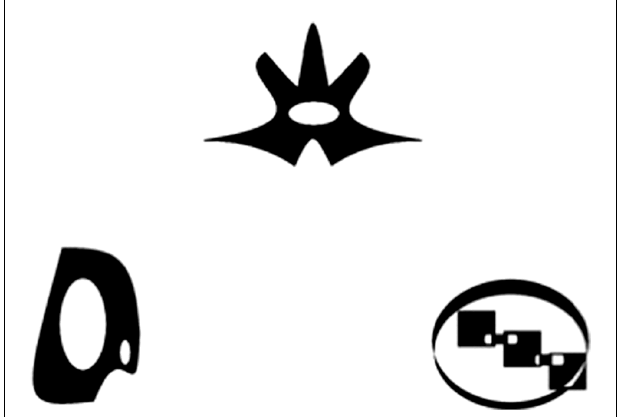
FIGURE 1 |An example of the visual array that participants saw in each familiarization trial.